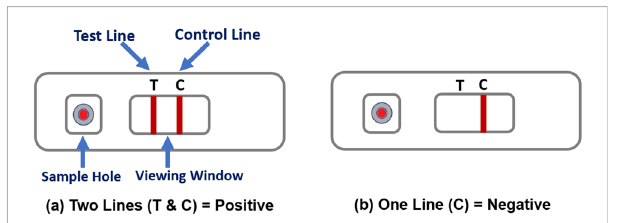
Figure 1. ( a ) structure of the testing device showing the sample hole, viewing window with the control line and test line as an example of positive result; ( b ) an example of negative result.